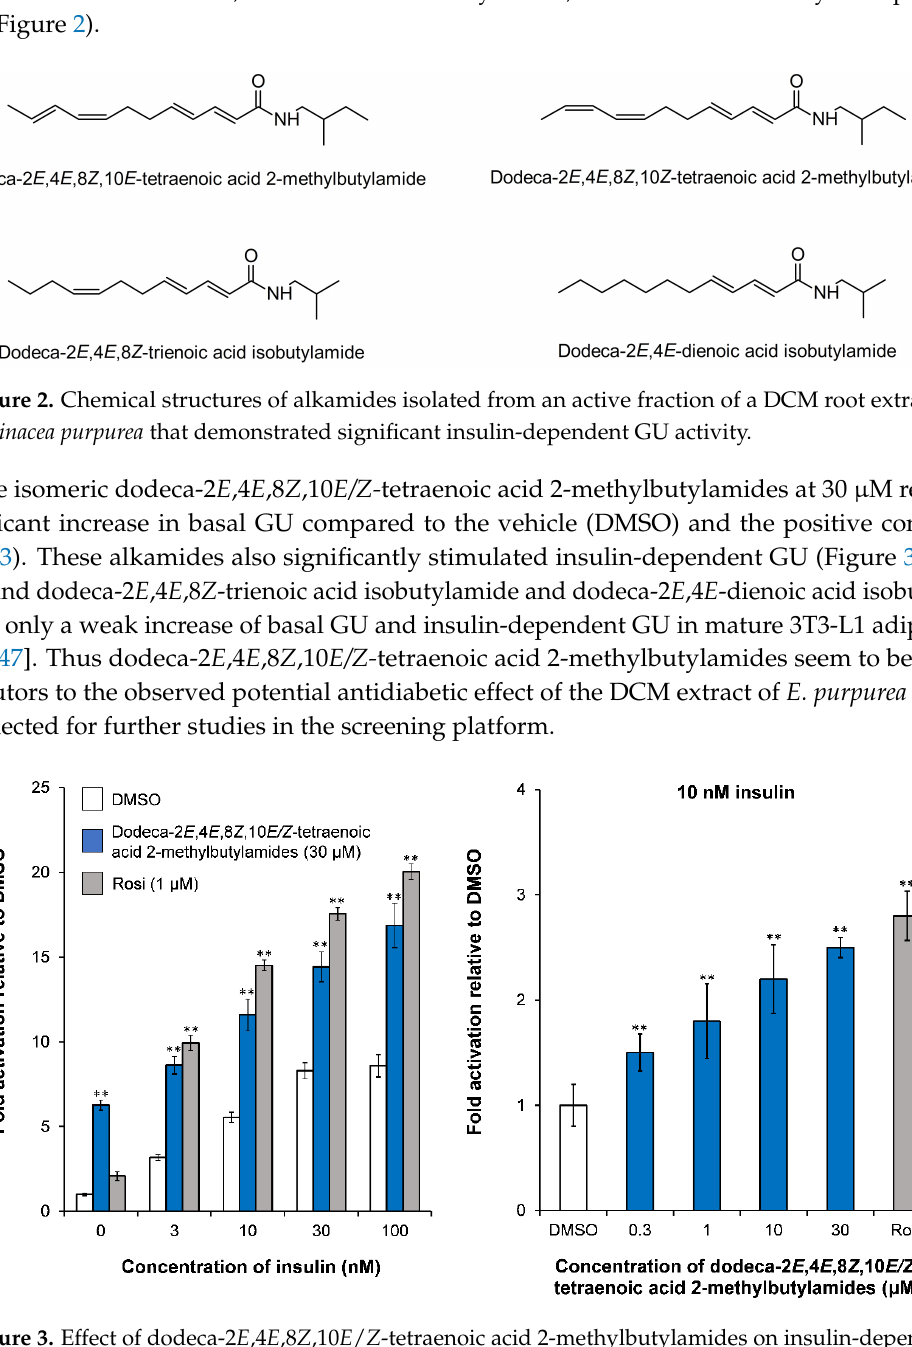
Figure 3. Effect of dodeca-2 E ,4 E ,8 Z ,10 E / Z -tetraenoic acid 2-methylbutylamides on insulin-dependent GU at 30 µ M in mature 3T3-L1 adipocytes and dose-dependent effect at 10 nM insulin. The results are normalized to the vehicle (DMSO), which was set to 1. Rosi (1 µ M) was the positive control. All values are expressed as a mean ± SD of three independent experiments in triplicates. ** p < 0.001 indicates significance relative to DMSO.